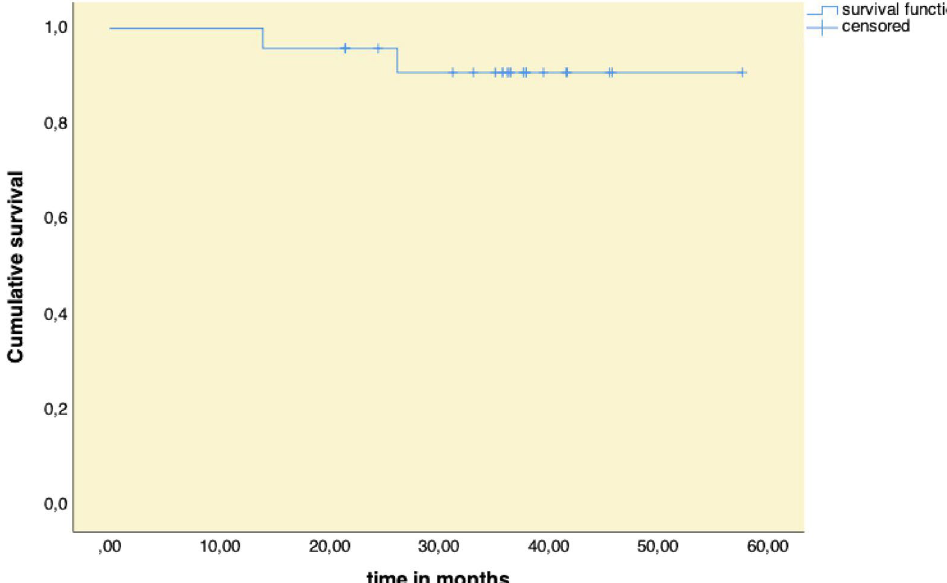
Fig. 5 Survival function according to Kaplan–Meier for all 24 implants treated by the LAPIDER concept